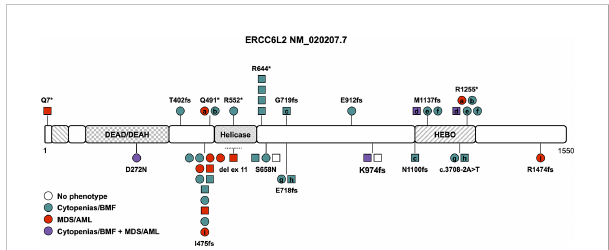
FIGURE 1 Schematic of the ERCC6L2 transcript (NM_020207.7) and its protein domains with the location of all reported germline variants. Circles represent females and squares represent males. Symbols on the same horizontal level are individuals from the same family. Letters within the symbols indicate individuals with compound heterozygous genotype, while symbols without letters indicate homozygosity for the variant. The color fi ll depicts different phenotypes, no color fi ll designates healthy individuals carrying homozygous/compound heterozygous causative variants. The dotted line shows the location of the sole described copy number variant. AML, acute myeloid leukemia; BMF, bone marrow failure;